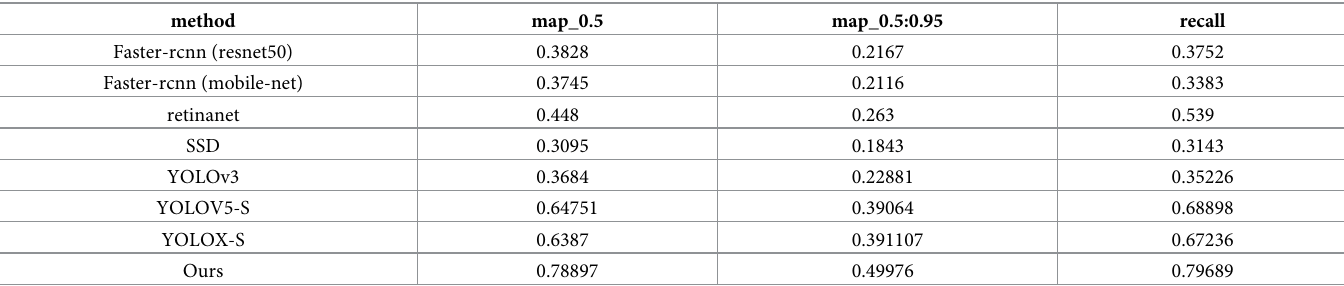
Table 1. The comparison of the performance in our datasets with the